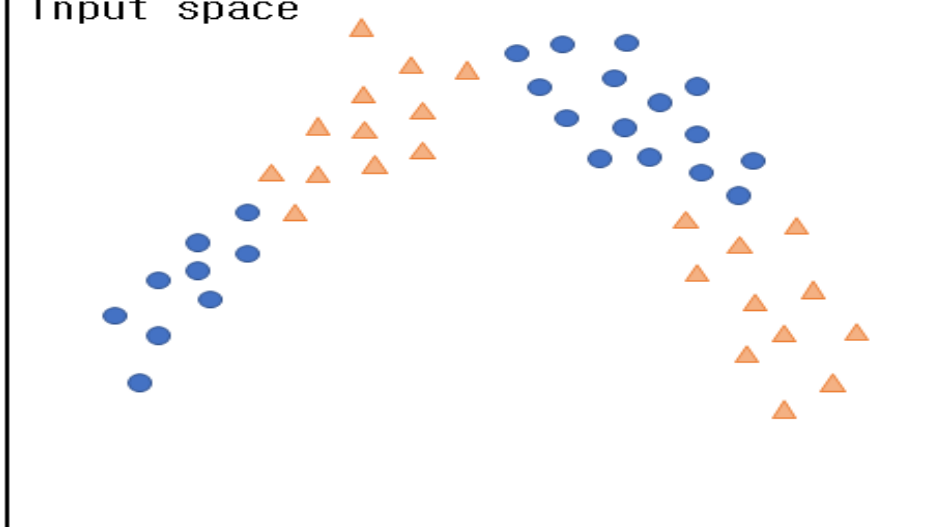
Figure 7. Data set with two features in the output space.